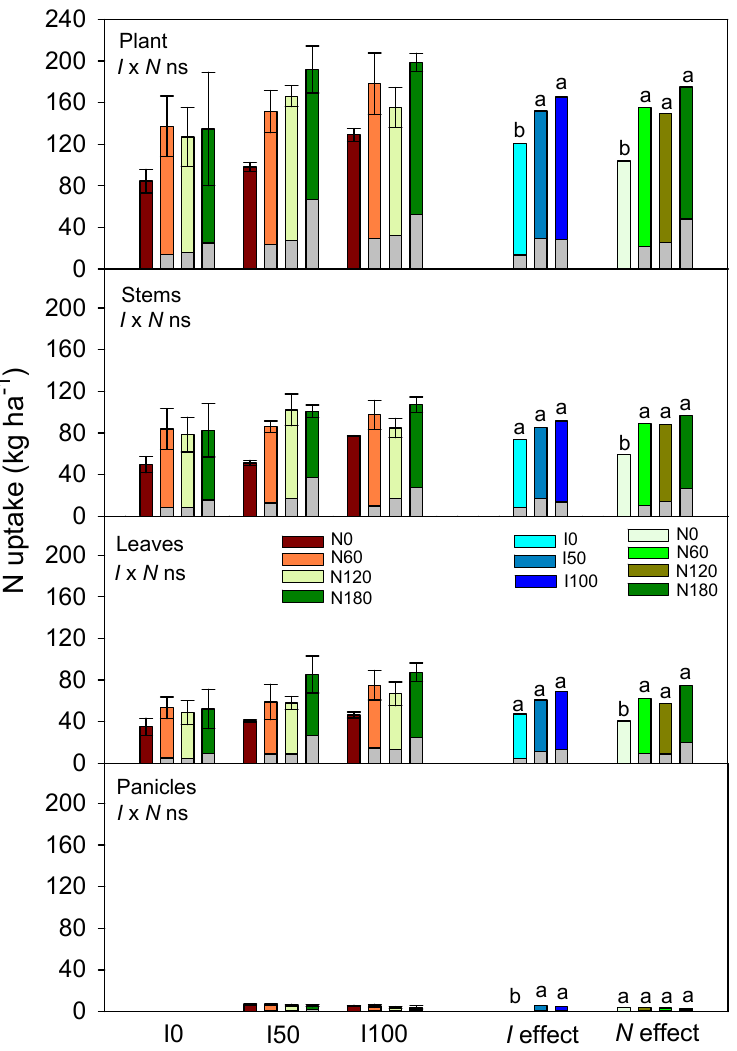
Figure 3. N uptake (kg ha − 1 ) in plant, stems, leaves, and panicles, in relation to irrigation (I0, I50, I00 = 0, 50, 100% ETc, respectively) and N level (N0, N60, N120, N180 = 0, 60, 120, 180 kg ha − 1 , respectively) in sweet sorghum cv. Keller. The grey part within each bar indicates the rate of N uptake derived from the fertilizer. Different letters for the main effects ( I = irrigation; N = N level) indicate significant differences at p ≤ 0.05. Black vertical bars indicate the standard error for total N uptake.